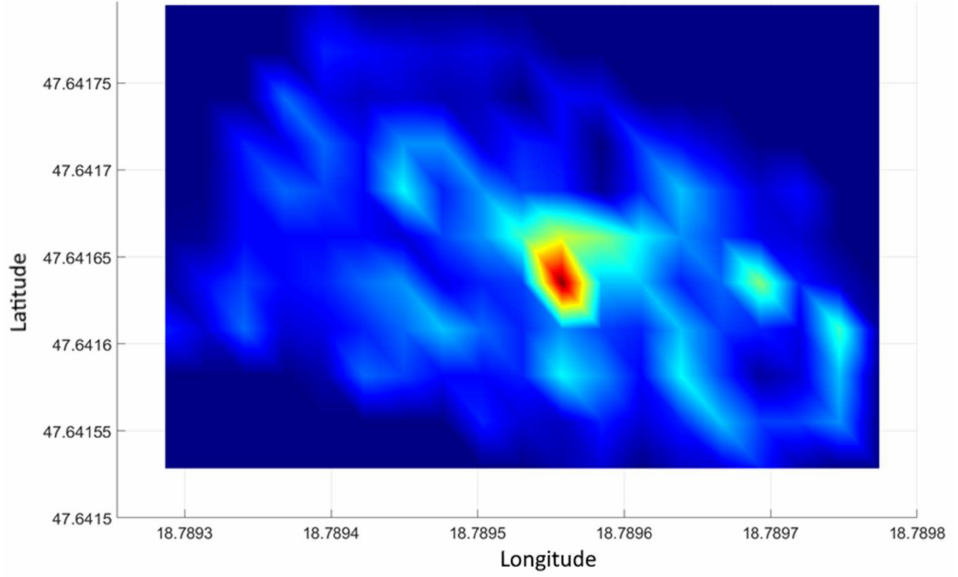
Figure 7. Distribution of gamma radiation intensity in the experimental area with 3 × 3 m processing